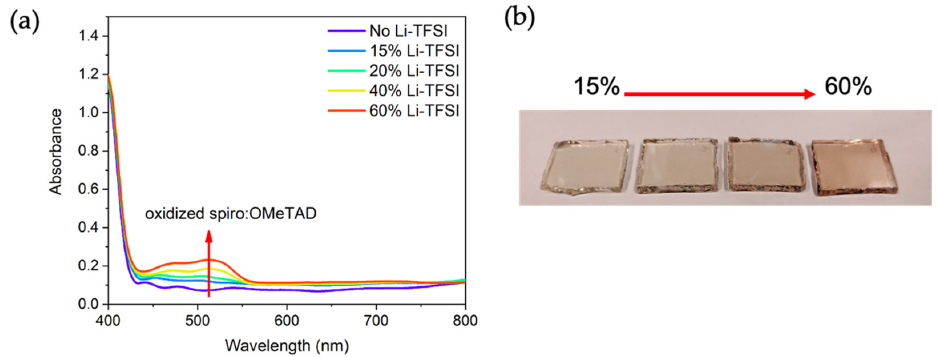
Figure 12. Optical properties of oxidized spiro-OMeTAD layers after 1 month in a desiccator in the dark. ( a ) UV-Vis spectra with different Li-TFSI contact; ( b ) optical picture.